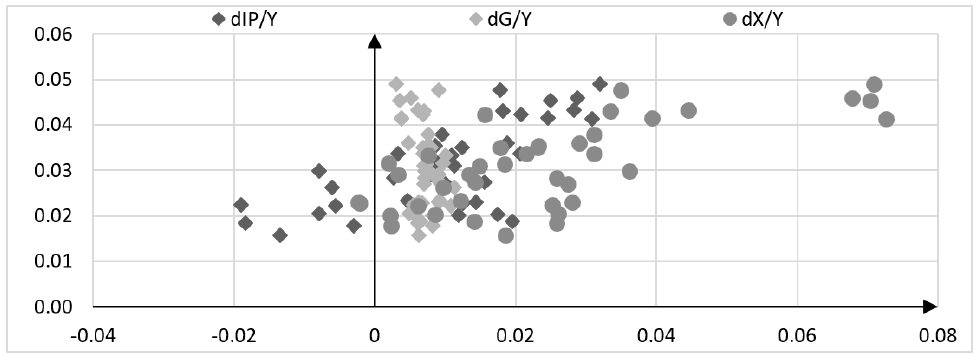
Figure 13. Correlation of changes in autonomous expenditure to changes in gross value added— France, own work, source: Eurostat.